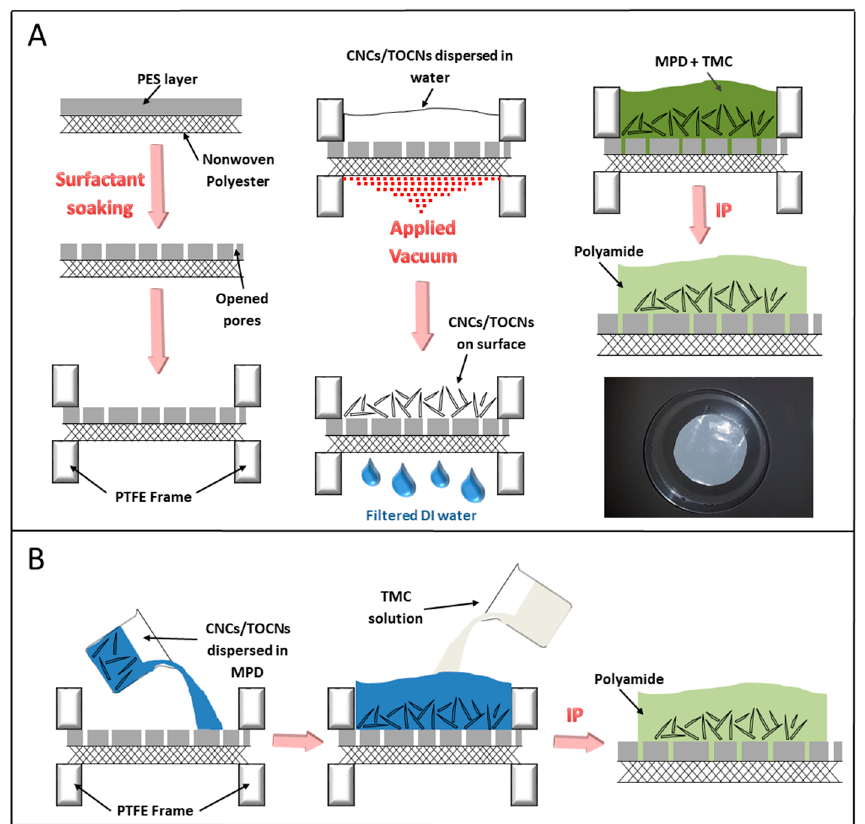
Figure 3. The CNC/TOCN nanocomposite membrane fabrication processes. ( A ) Vacuum filtration method; ( B ) monomer dispersion method. Adapted with permission from W. Chan, H. Chen, A. Surapathi,